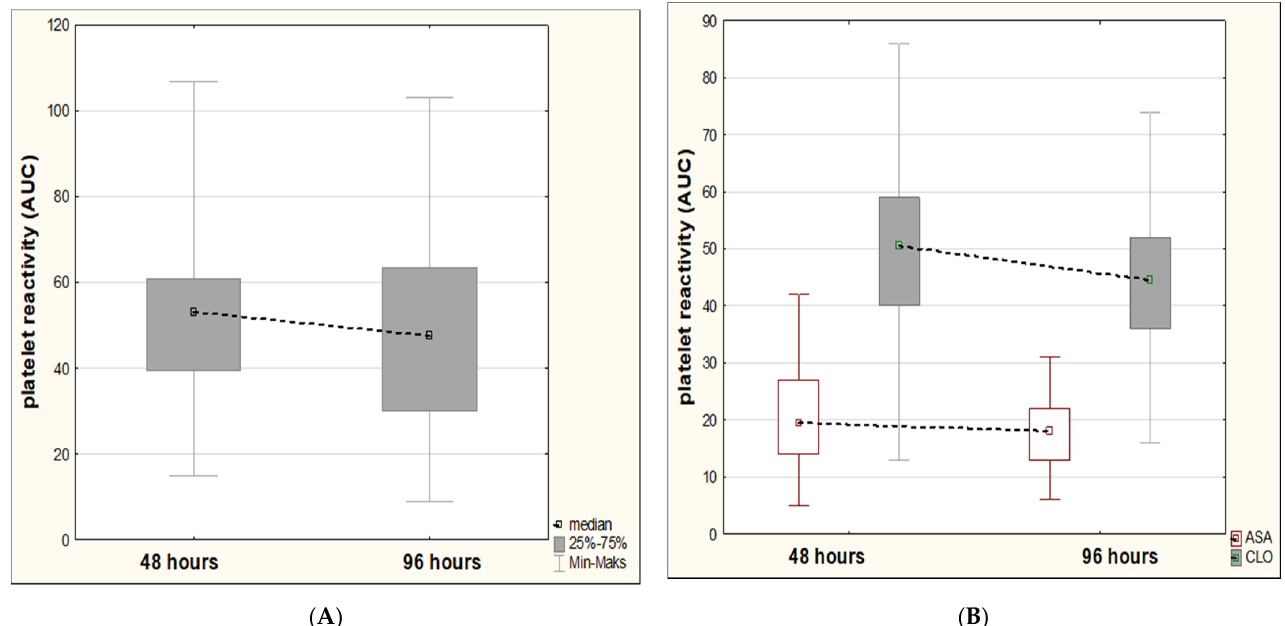
Figure 1. The overall dynamics of platelet reactivity (in area under the curve units, AUC) over time. ( A ) The group on clopidogrel alone. The insignificant decrease in platelet reactivity between two assessments at 48 and 96 h. ( B ) The group on dual antiplatelet therapy. The insignificant decrease in platelet reactivity on aspirin (ASA) and a trend towards a more favorable decrease in platelet reactivity on clopidogrel (CLO).